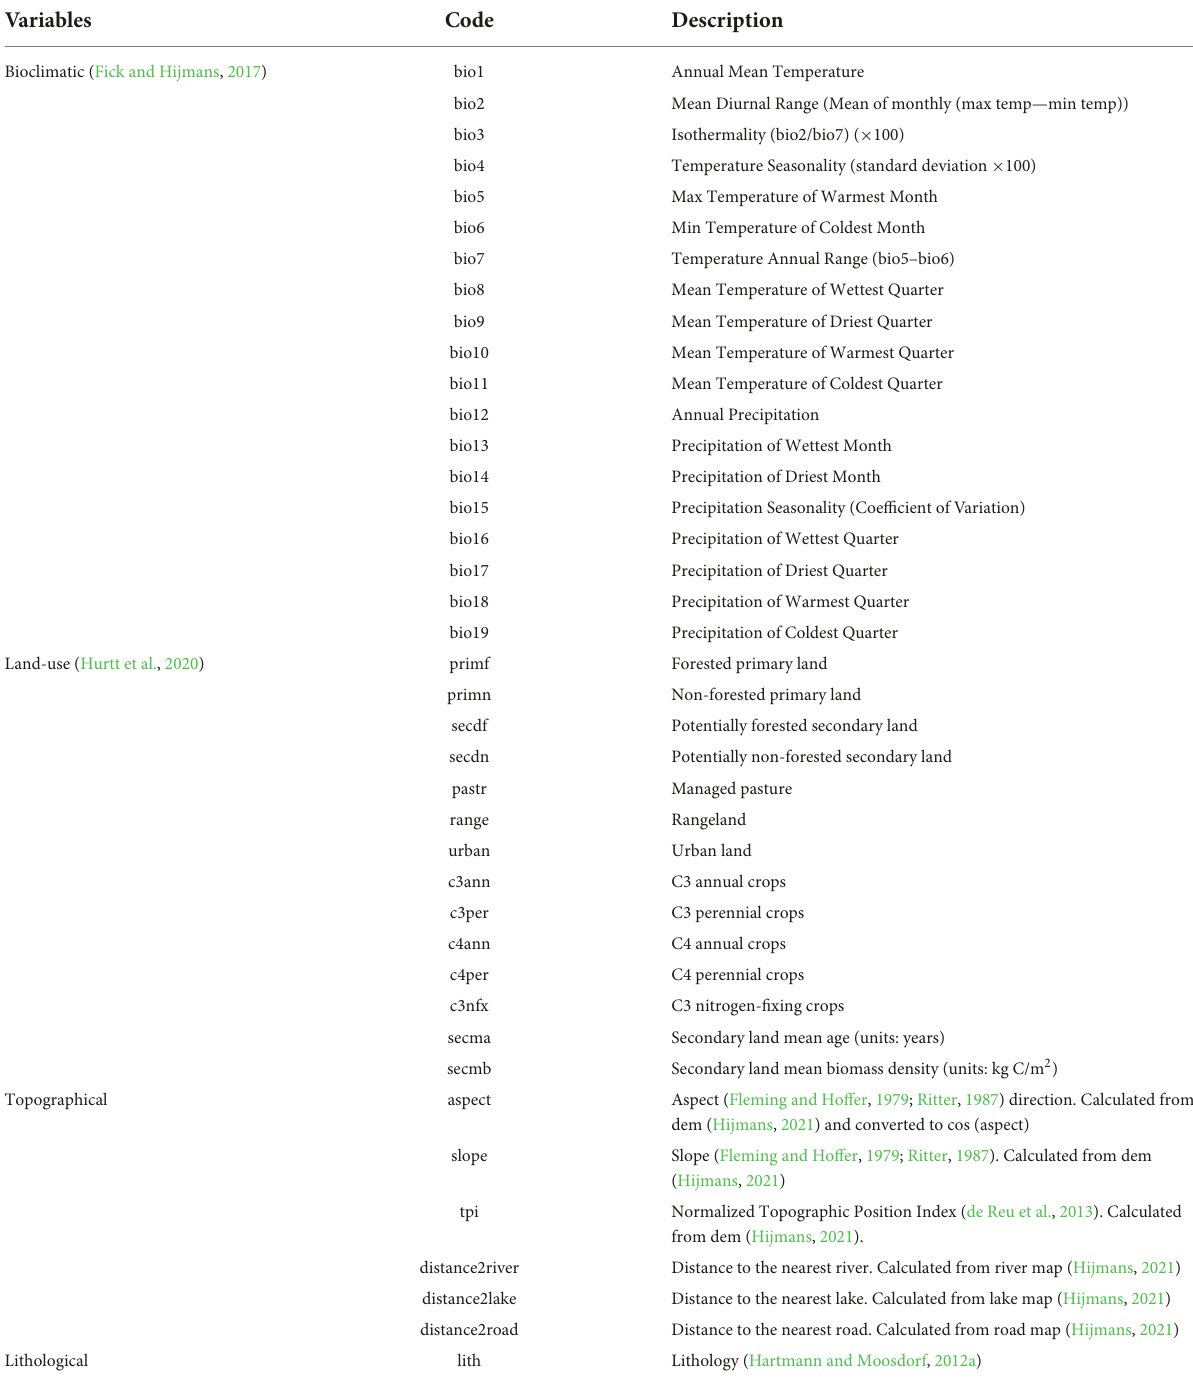
TABLE 2 Environmental variables used in the model